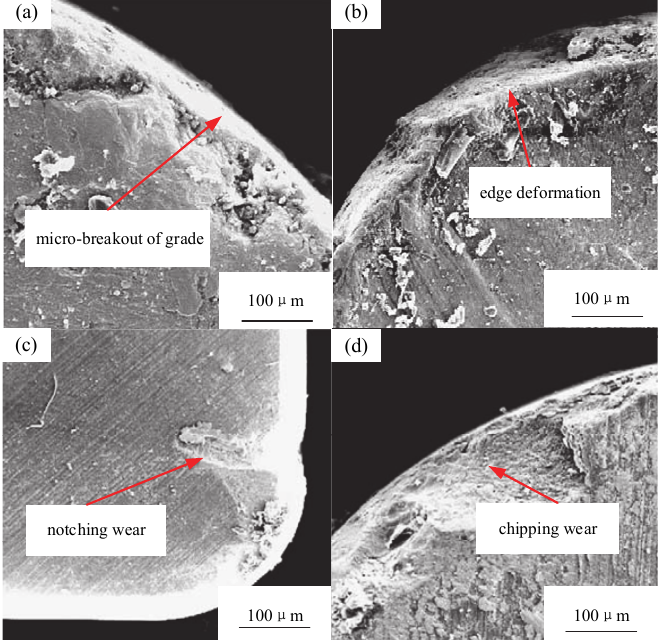
Figure 4. SEM micrographs of blade wear. Tool material: ( a ) KC732; ( b ) KC935; ( c ) KY210; ( d ) KY3000